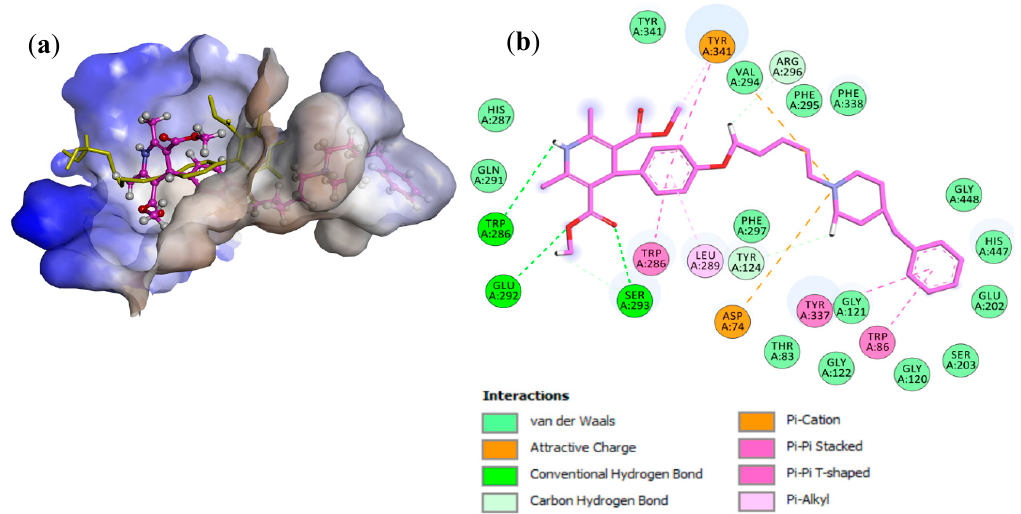
Figure 2. ( a ) Three-dimensional surface representation of hAChE with compounds 3h (pink) and 3d (yellow). ( b ) Two-dimensional schematic view of the interactions between 3h and hAChE.